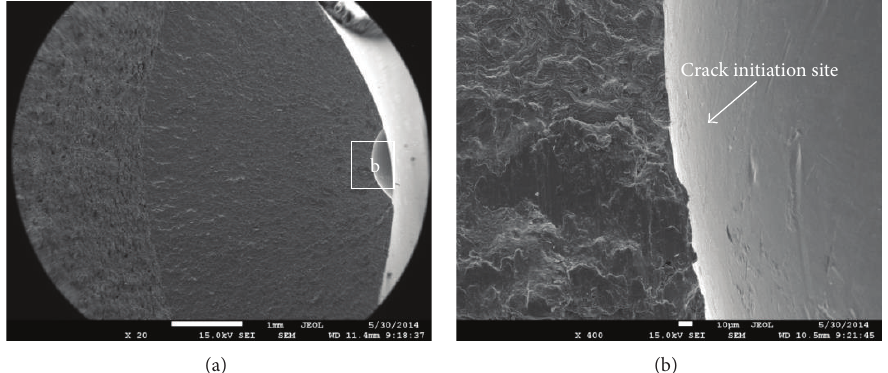
Figure 8: Typical fracture surface of the indented UCN: (a) fracture surface and (b) crack initiation site.